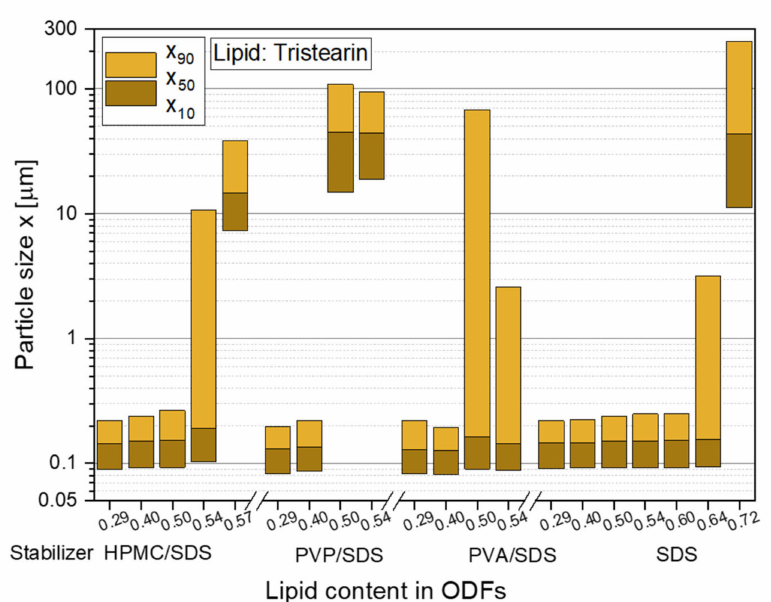
Figure 3. Particle size distributions of solid lipid tristearin nanoparticles redispersed from ODFs with various lipid contents and formulated with different stabilizers. The particle size distributions of the original lipid nonosuspensions are shown in Figure